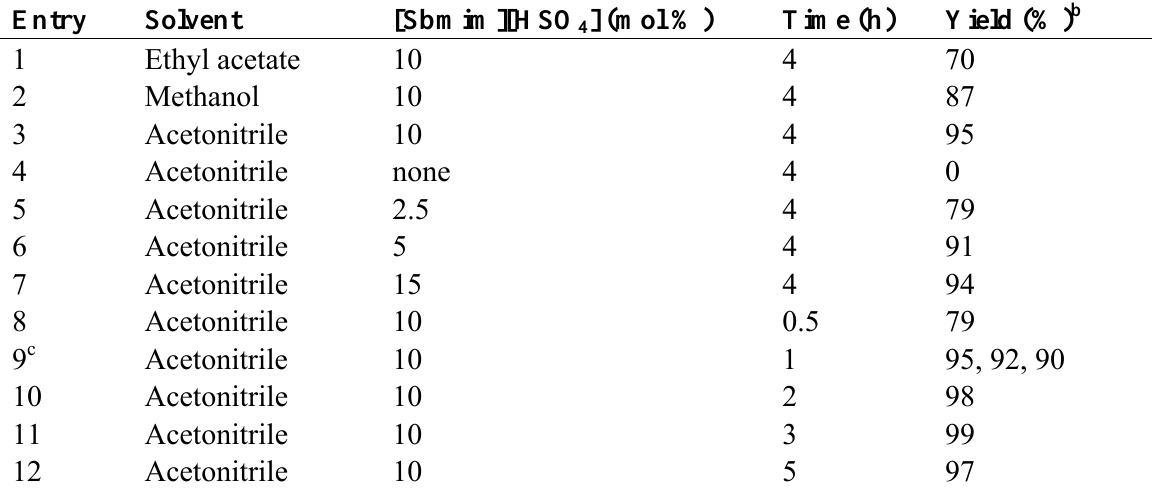
] in the reaction of indole and 1-phenyl-3-(2- 4